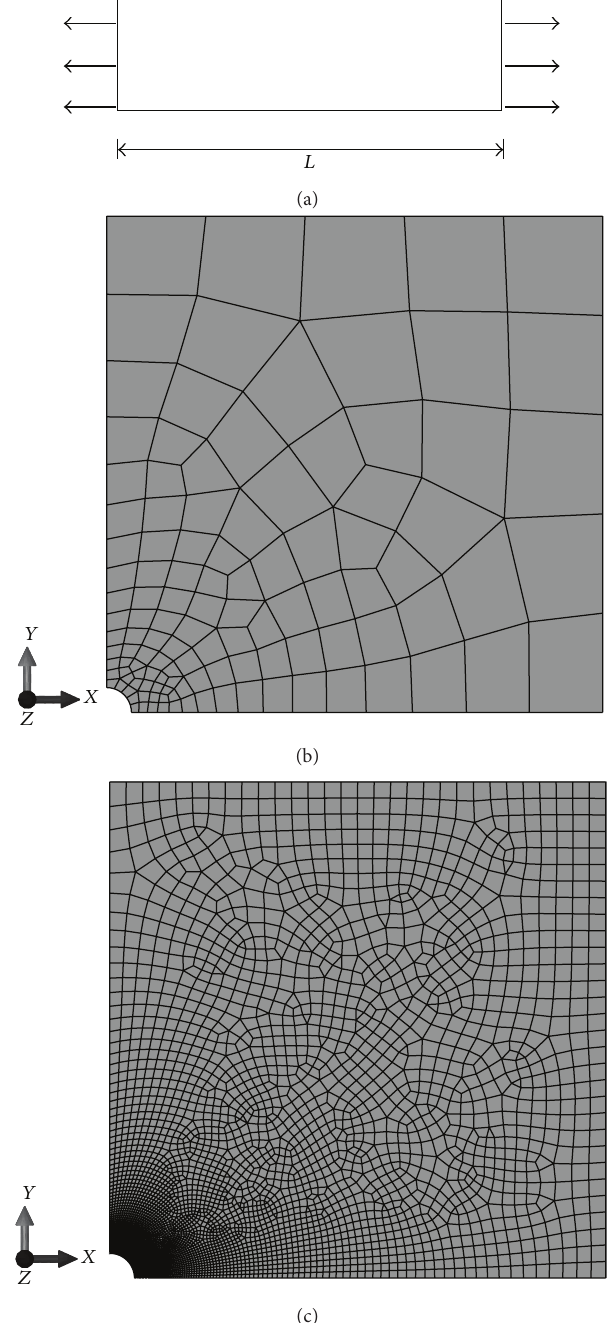
Figure 23: (a) An infinite piezoelectric plate with a circular hole subjected to remote stress. (b) Mesh used by HFS-FEM. (c) Mesh used by